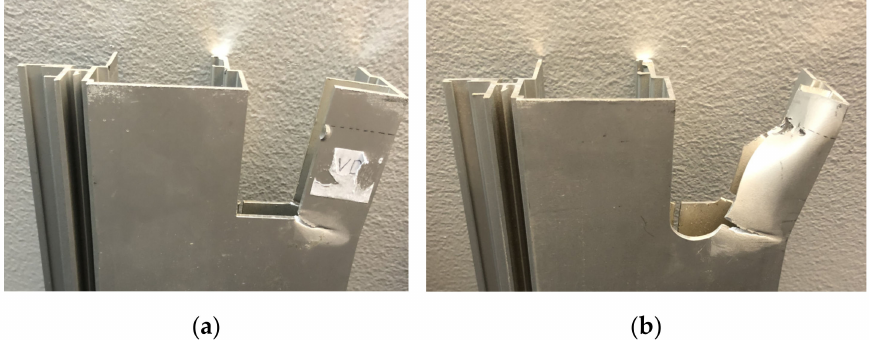
Figure 10. Fractureinmonotonictests: ( a )SharpnotchspecimenM_N1_1; ( b